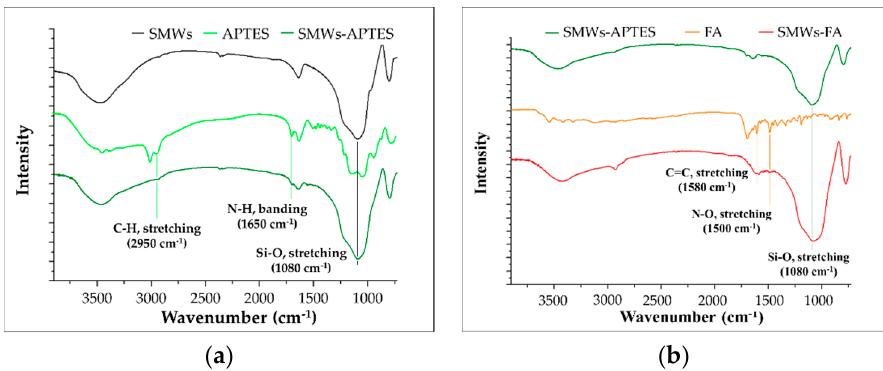
Figure 1. ( a ) FT–IR spectrum of APETS conjugated silica microwires (SMWs); ( b ) folic acid (orange) and folic acid conjugated SMWs (red). All samples were pelleted using KBr, and the mass ratio of the sample and KBr was 1:100.